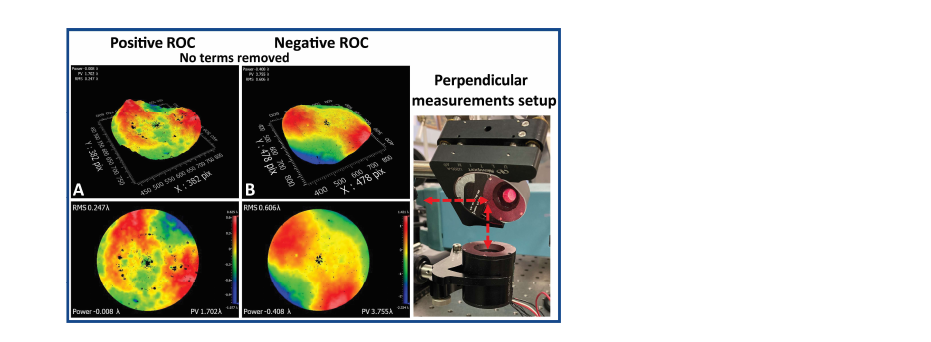
Figure 7. ( A ) Positive and ( B ) negative ROC, 2D and 3D surface representation for the perpendicular setup. Right side shows a picture of the setup.